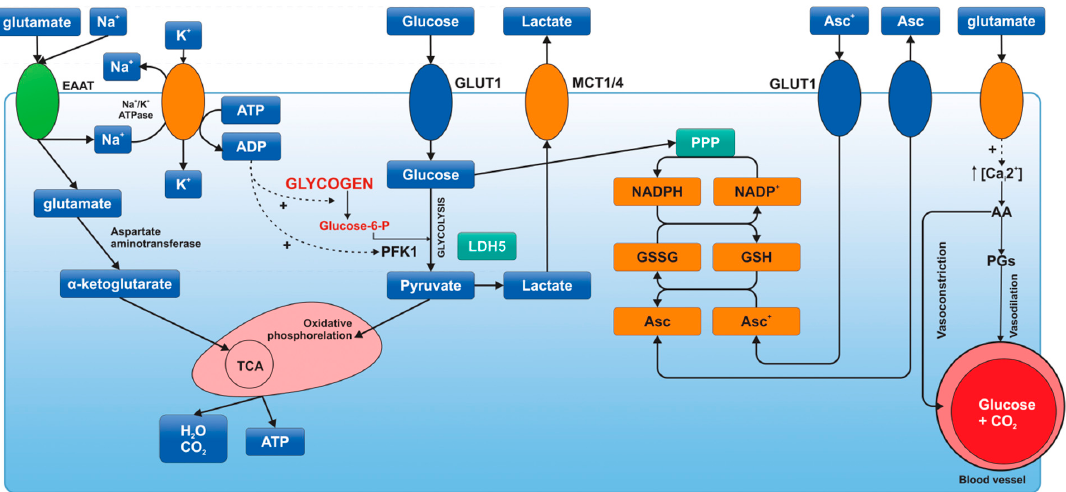
Figure 2. Metabolic activation of astrocytes [40]. Synaptic activity produces an increase in extracellular K + , which stimulates Na + K + -ATPase by binding of its extracellular K + -sensitive site. The excitatory neurotransmitter glutamate is taken up by astrocytes through excitatory amino acid transporters. This kind of transport produces an increase in intracellular Na + , which stimulates Na + K + -ATPase by binding of its intracellular Na + -sensitive site. Na + K + -ATPase activation produces a decrease in ATP/ADP ratio, thus glycolysis and glycogenolysis activation. In addition, glucose is oxidized by pentose phosphate pathway (PPP) to produce NADPH and to maintain the redox balance, reducing glutathione and ascorbic acid (Asc). Ascorbic acid released by astrocytes is taken up by neurons to protect themselves from oxidant species (ascorbic acid is oxidized in neurons). Oxidized ascorbic acid (dehydroascorbic acid, Asc + ) is released from neurons and taken up by astrocytes through GLUT1. In astrocytes, glutamate is able to bind ionotropic receptors, which are predominantly calcium channels. This Ca 2+ increase cooperates with Krebs cycle (TCA) activation and produces arachidonic acid (AA) and prostaglandin (PGs), which stimulate the constriction and dilation of capillaries, respectively. ADP: adenosine diphosphate; ATP: adenosine triphosphate; EAAT: excitatory amino-acid transporter; GLUT: glucose transporter; G-6-P: glucose 6-phosphate; GSSG: glutathione disulfide; GSH: glutathione; LDH: lactate dehydrogenase; MCT: monocarboxylate transporter; Na + K + -ATPase: sodium-potassium pump; NADP + : nicotinamide adenine